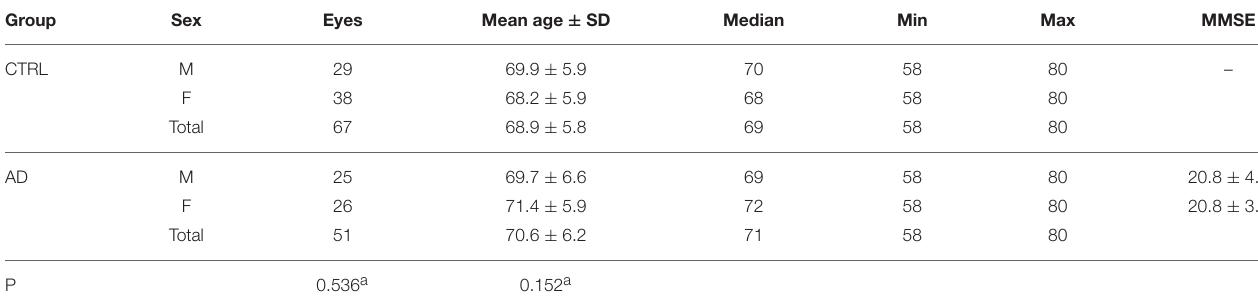
TABLE 1 | Descriptive analysis of the Alzheimer and control groups. Group